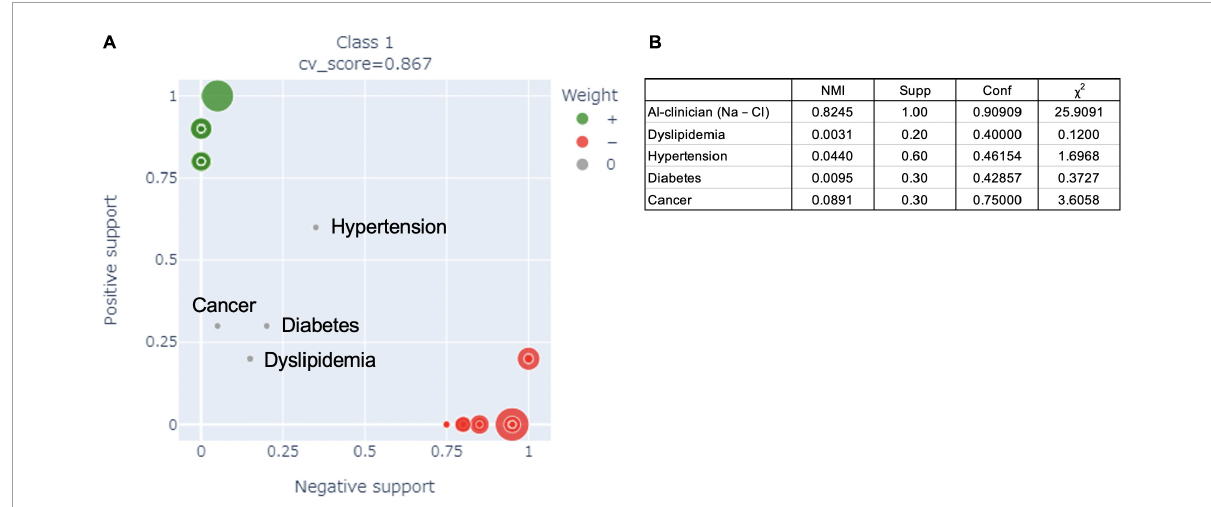
FIGURE3 (A) Comparison of the performance of the AI-clinician model and risk factors in the published literature for predicting the need for supplemental oxygen based on characteristics and laboratory biomarkers of patients with COVID-19. The green dots show the AI-clinician model’s performance in predicting oxygen needs in patients with COVID-19. The red dots show the AI-clinician model’s performance in predicting when patients with COVID-19 do not need oxygen support. (B) Model performance evaluations in AI-clinician model and risk factors in the published literature for predicting the need for supplemental oxygen based on characteristics and laboratory biomarkers of patients with COVID-19. NMI, normalized mutual information; Supp, ratio of positive hit samples to all positive samples; Conf, ratio of positive hit samples to all hit samples; χ 2 , Chi-squared value.